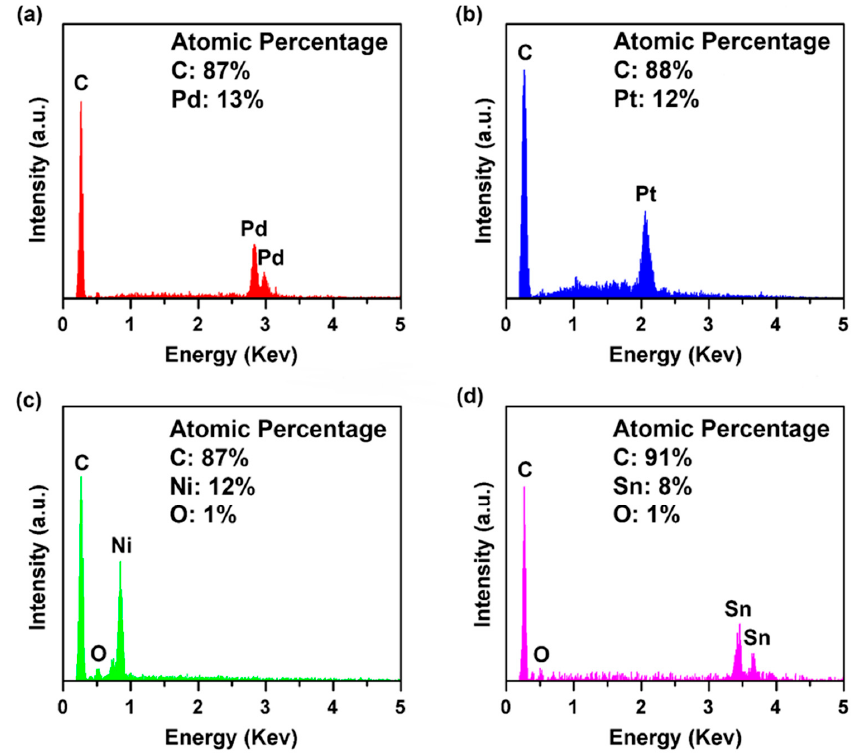
Figure 6. EDS spectra of ( a ) palladium, ( b ) platinum, ( c ) nickel, and ( d ) tin loaded rGO aerogels after hydrogen reduction.